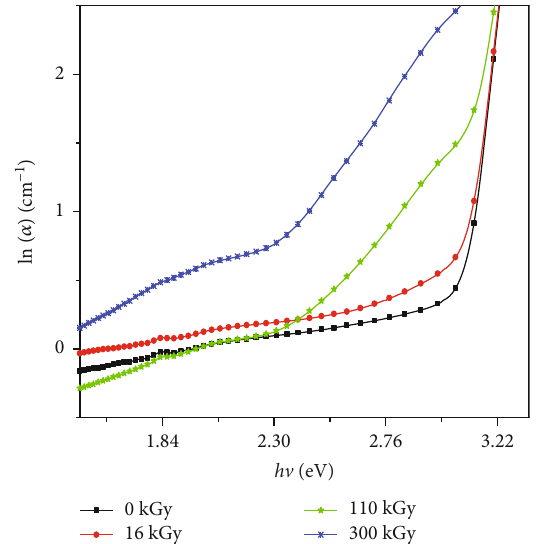
Figure 4: The dependence of natural logarithm of α on photon energy for virgin and gamma-irradiated UHMWPE